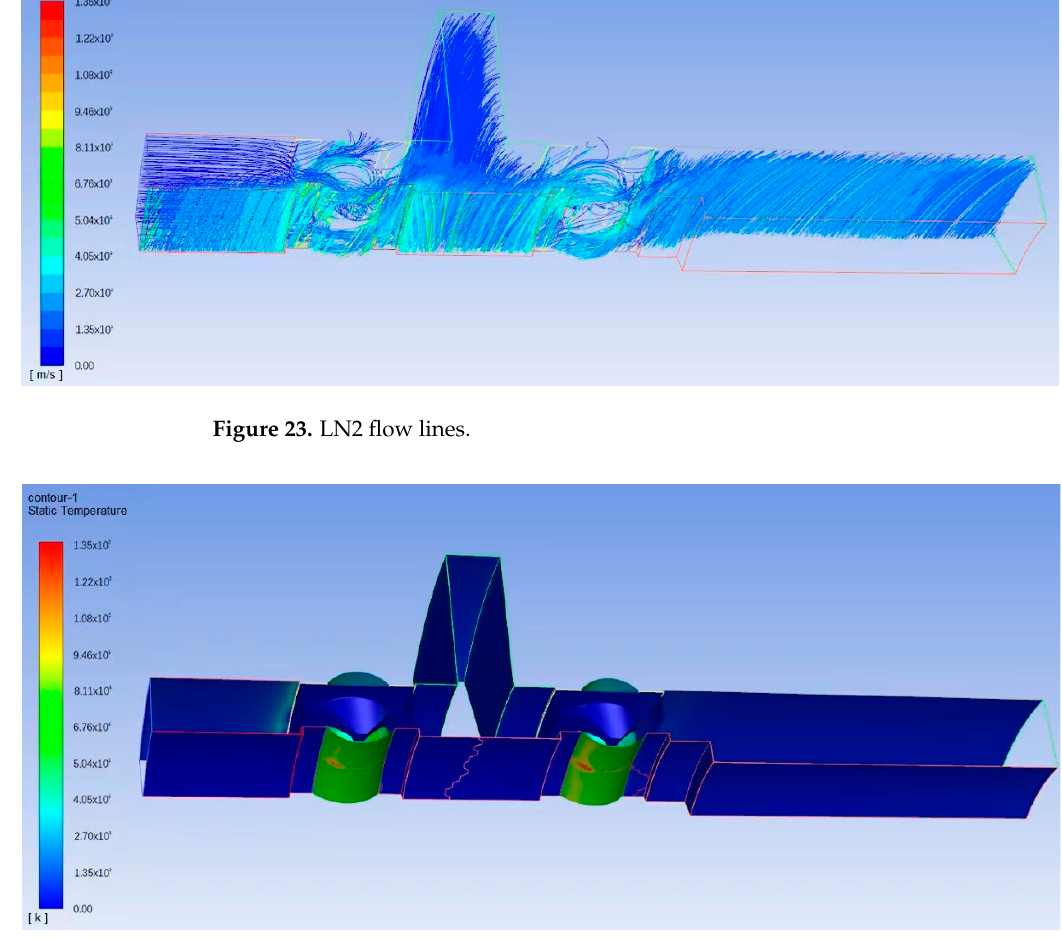
Table 7. Temperature, pressure, and flow of LN2.